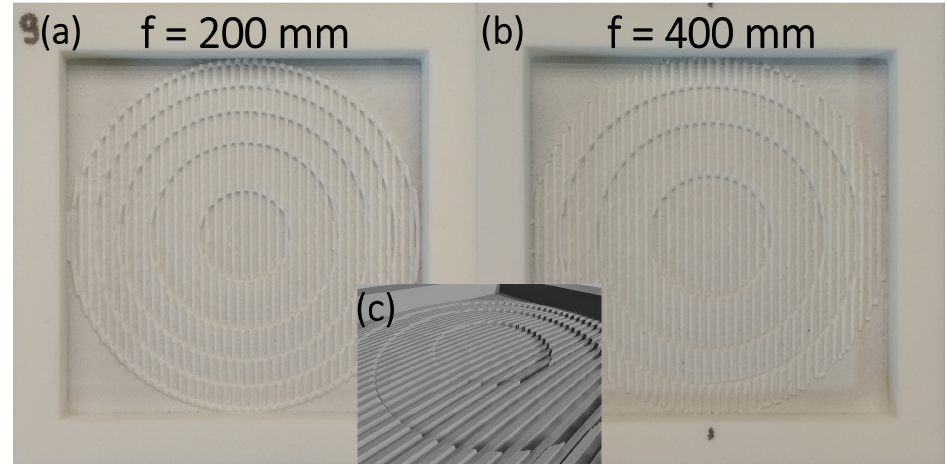
Figure 4. The photographs of DOEs with ( a ) f = 200 mm and ( b ) f = 400 mm manufactured by the SLS method from PA2200 (polyamide 12). The inset ( c ) shows the fragment of the 3D visualization of the f = 400 mm structure.